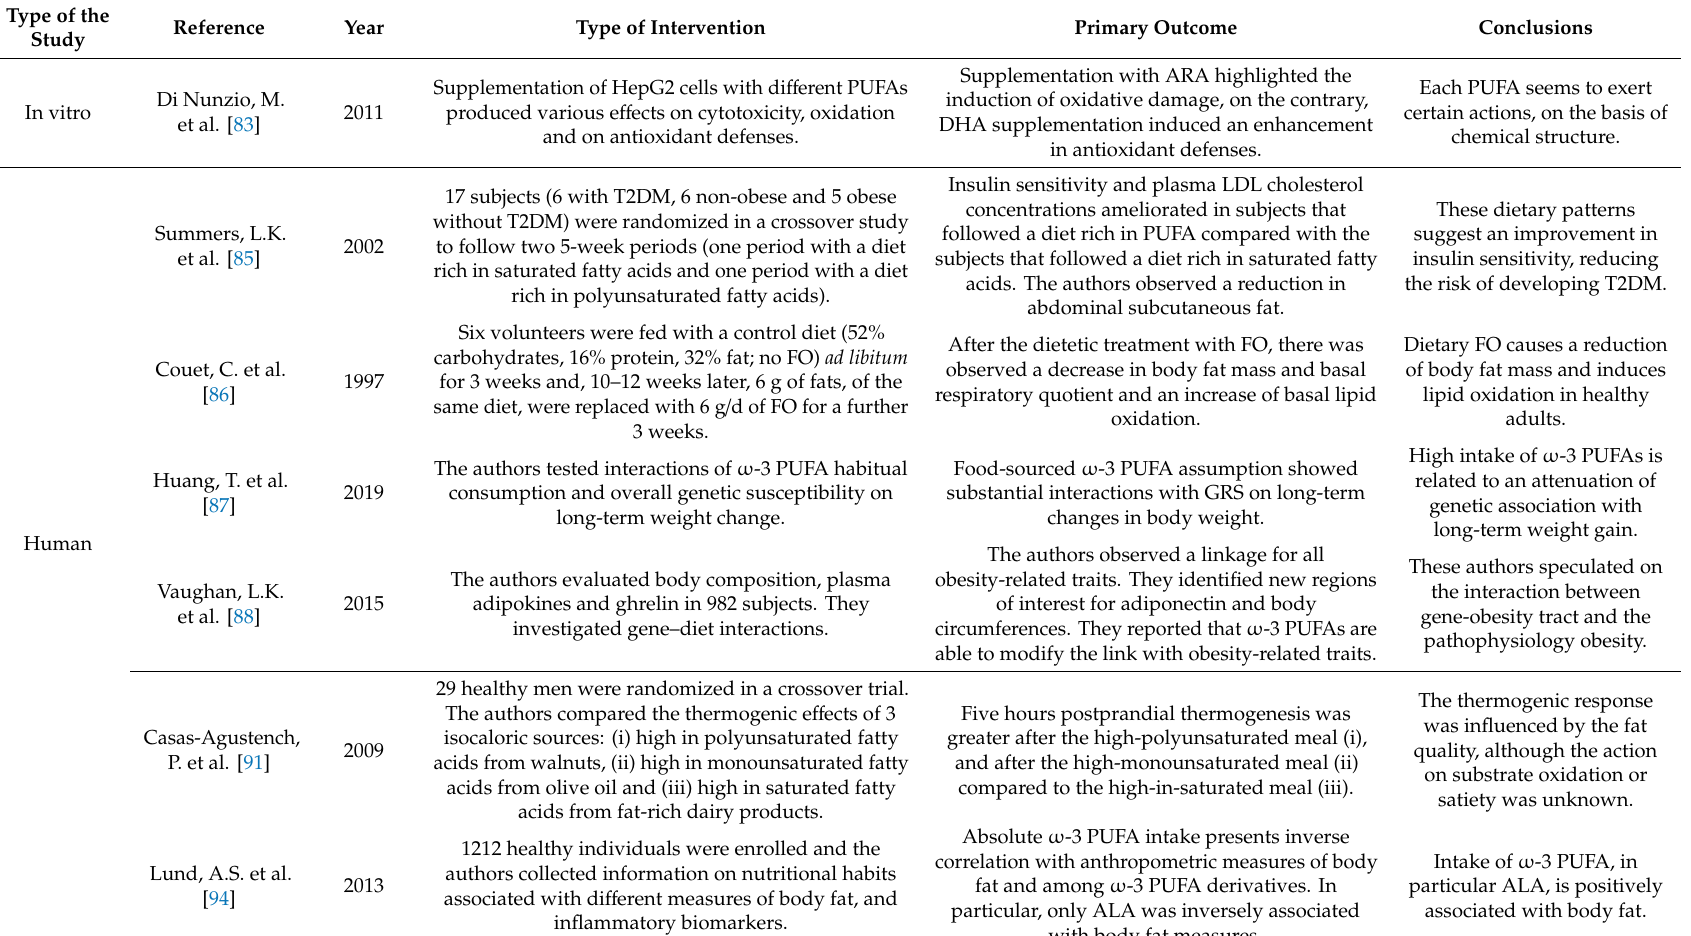
Table 4. Studies on impact of PUFA consumption on body